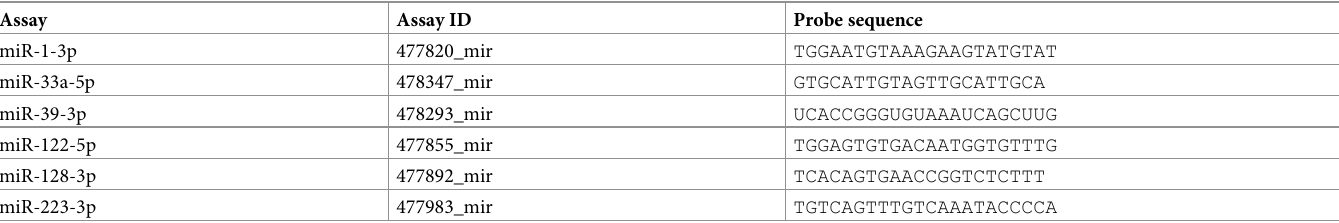
Table 2. Sequences of probes used for TaqMan advanced miRNA